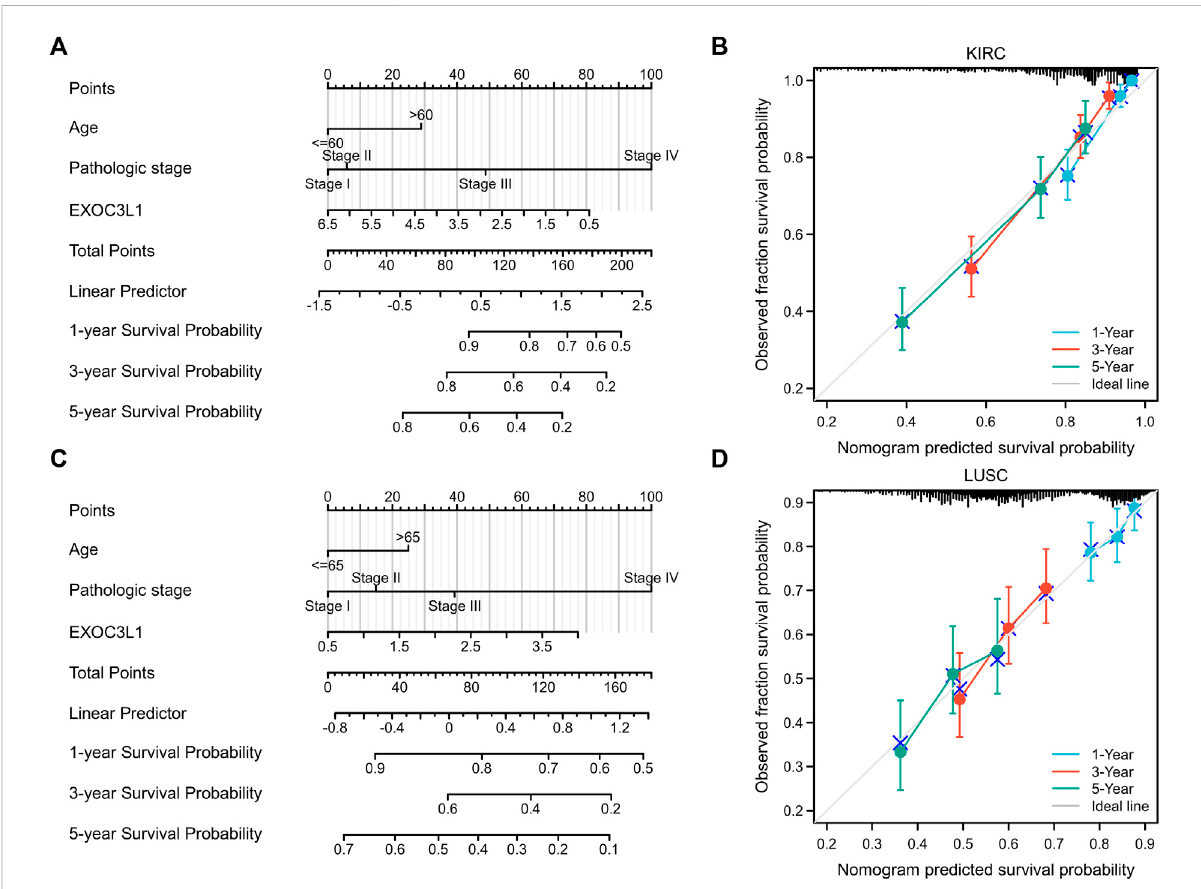
FIGURE 7 Nomogram models were established and evaluated in KIRC and LUSC. (A) Establishment of a nomogram model incorporating EXOC3L1 expression in KIRC. (B) Calibration curves were used to evaluate the nomogram model in KIRC at 1-year, 3-year, and 5-year. (C) Building a nomogrammodelcontainingEXOC3L1expressioninLUSC. (D) The1-year,3-yearand5-yearcalibrationcurveswereusedtoevaluatetheprediction accuracy of the nomogram model in